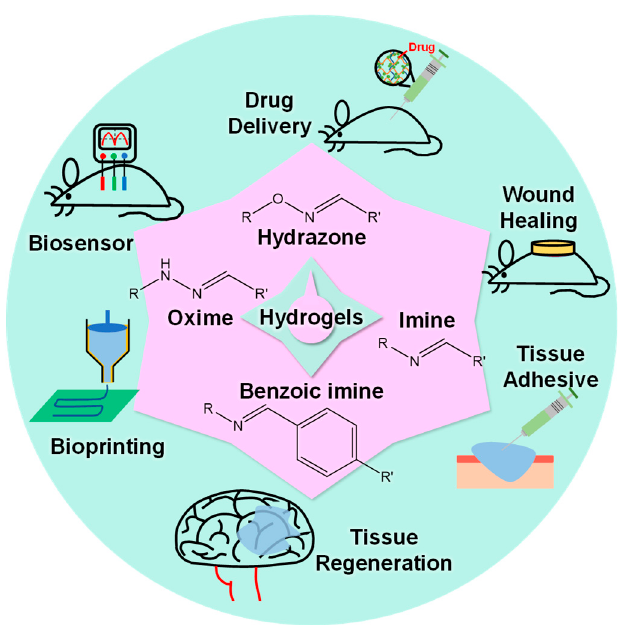
Figure 1. Summary of biomedical applications for hydrogels based on various Schiff base linkages.